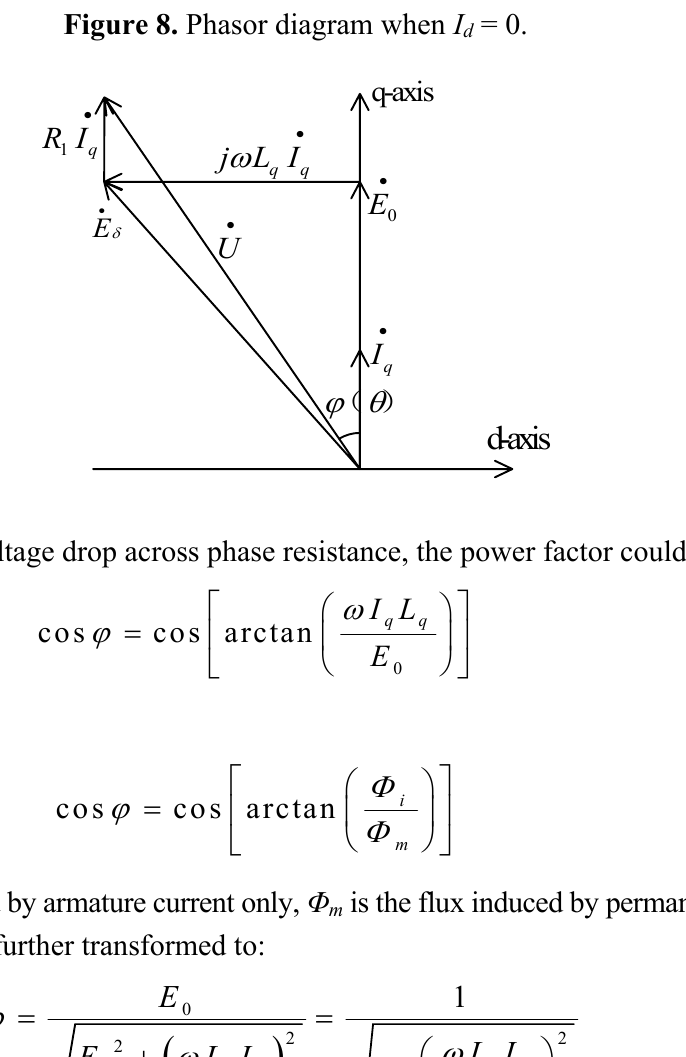
Figure 8. Phasor diagram when I